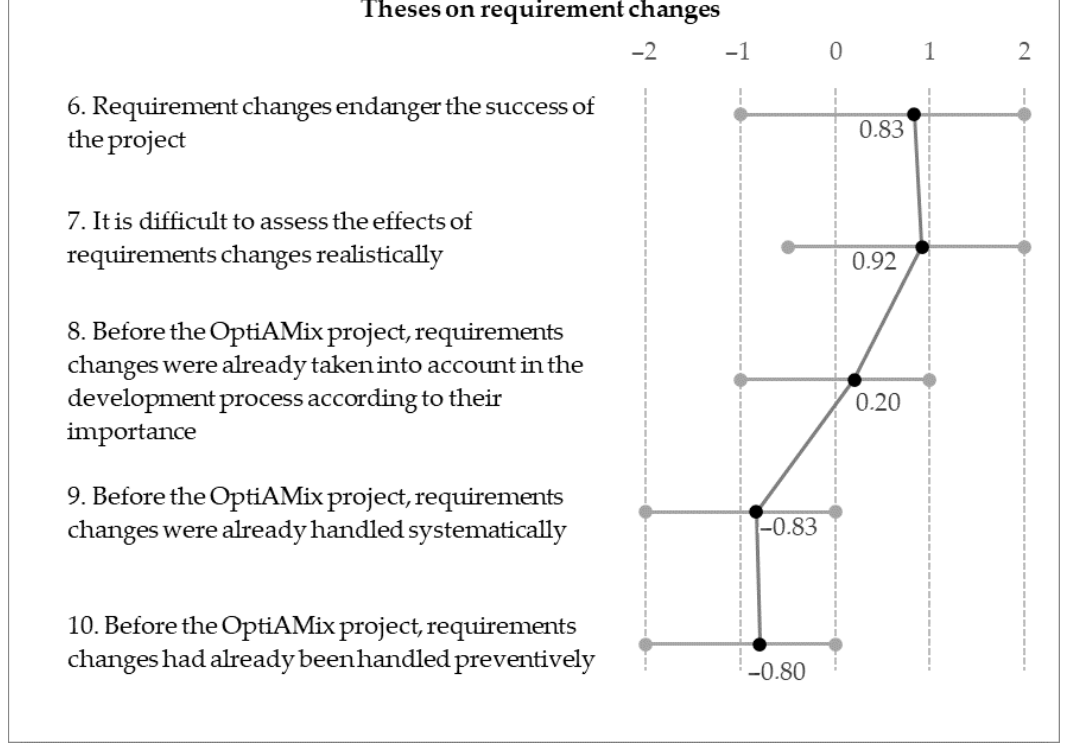
Figure A1. Questionnaire results on area “requirement changes (general)”.